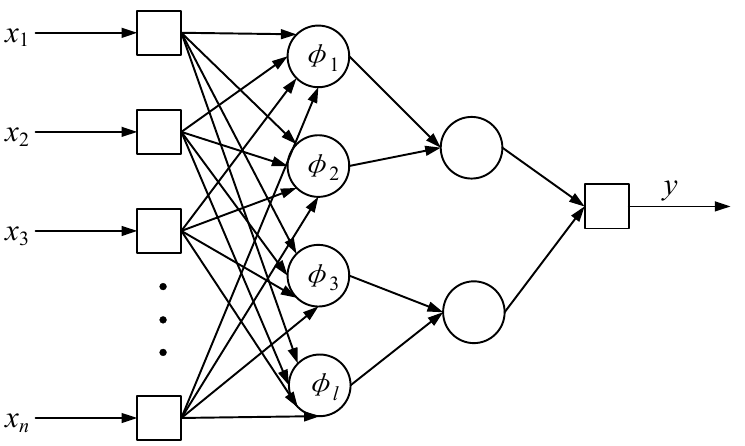
Figure 1. PNN network structure.